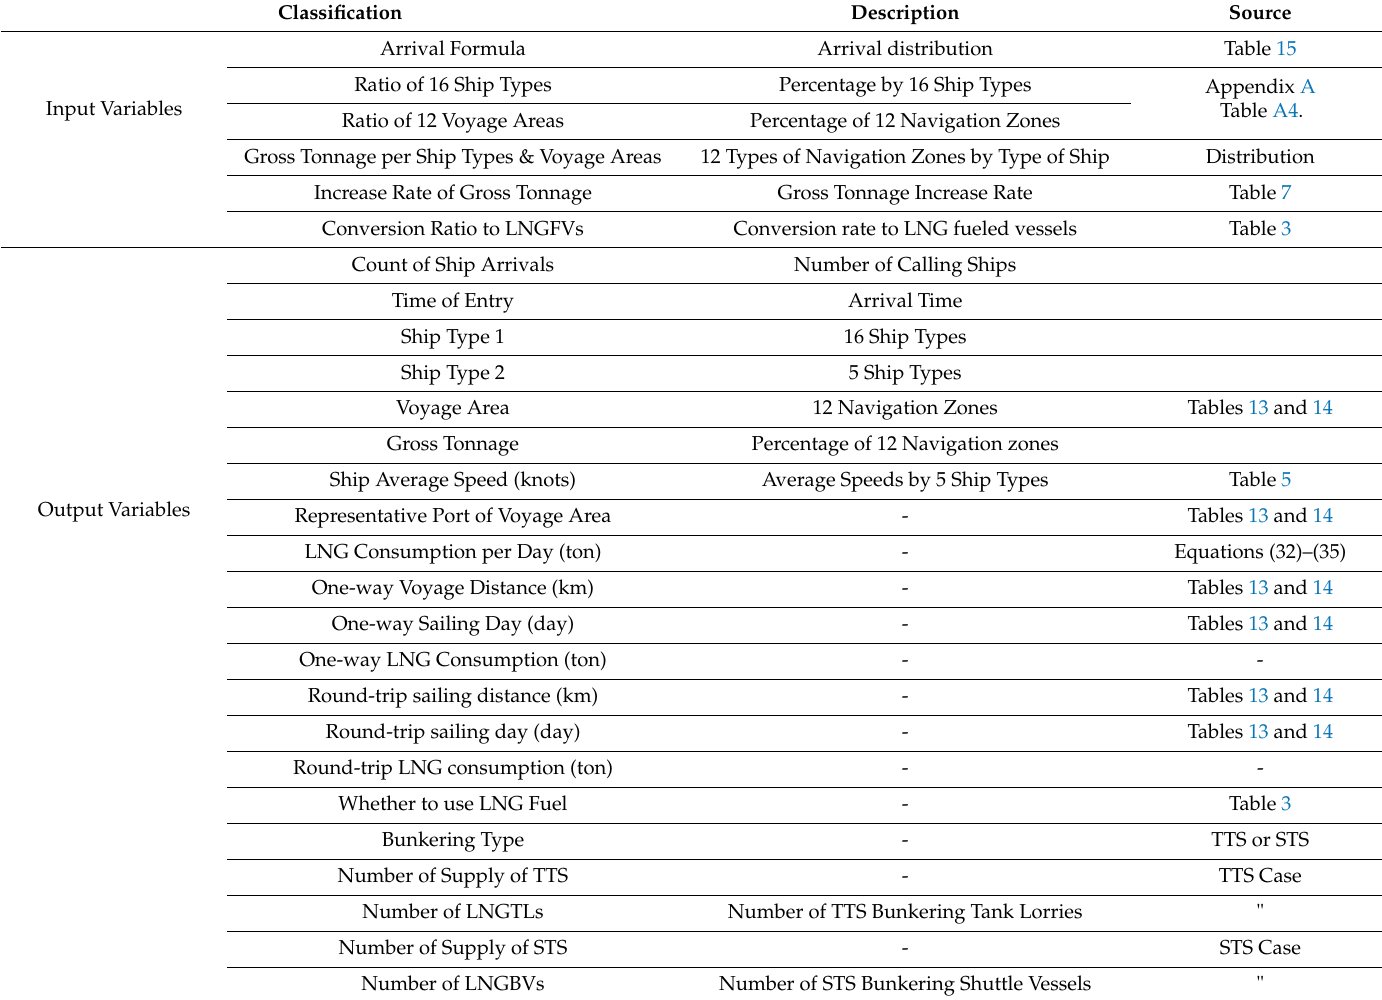
Table 16. Design Input and Output Variables of Simulation